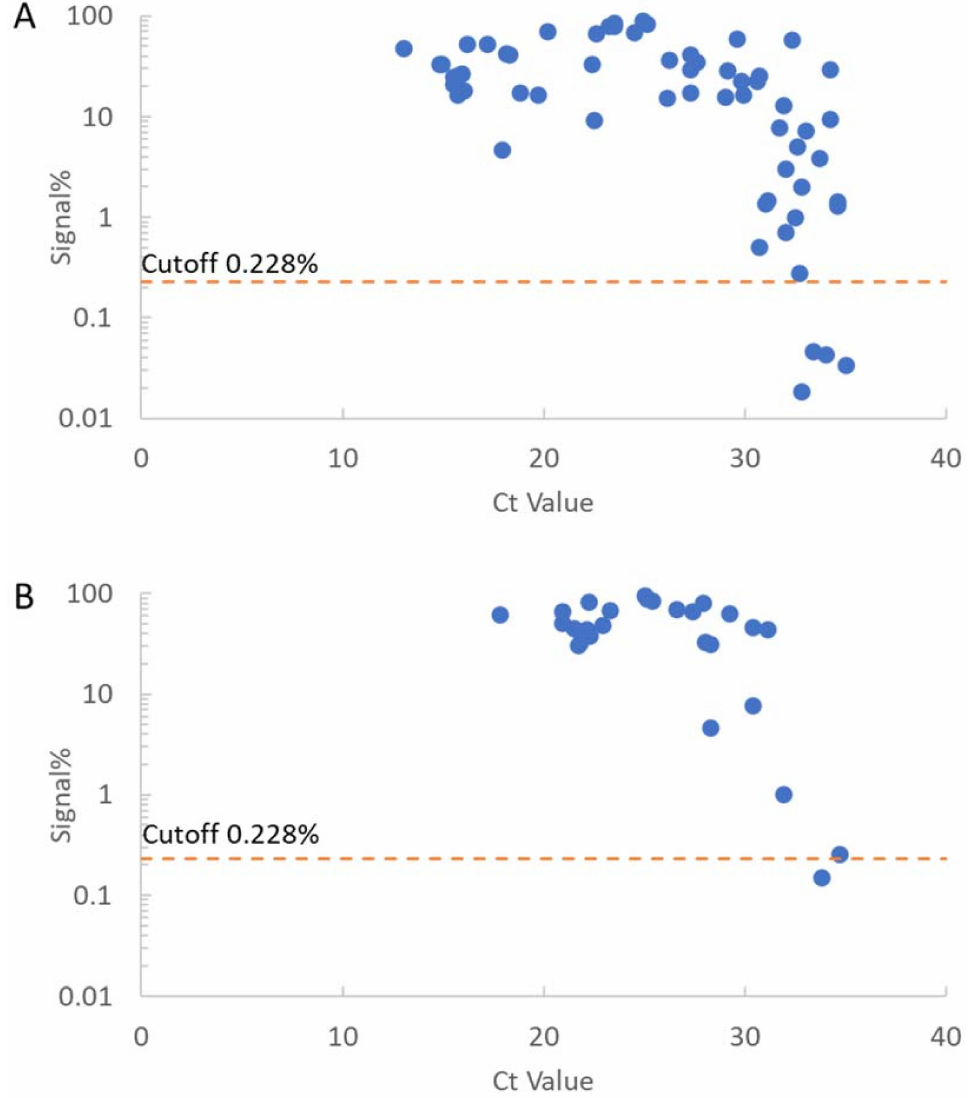
Figure 4. Measurement of RT-PCR-positive specimen and dose response with RT-PCR-positive specimen. ( A ) Results of 61 RT-PCR-positive NP swab specimens from Toho University. ( B ) Results of 27 RT-PCR-positive NP swab specimens from Yokohama City